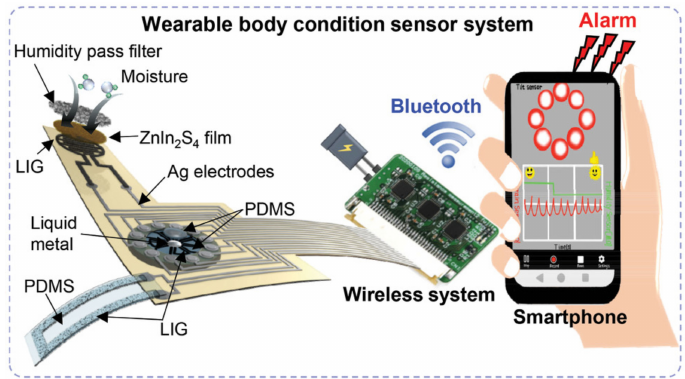
Figure 8. The integrated multi-modal wireless system with feedback functions. Reproduced with permission from [21]. Copyright 2021